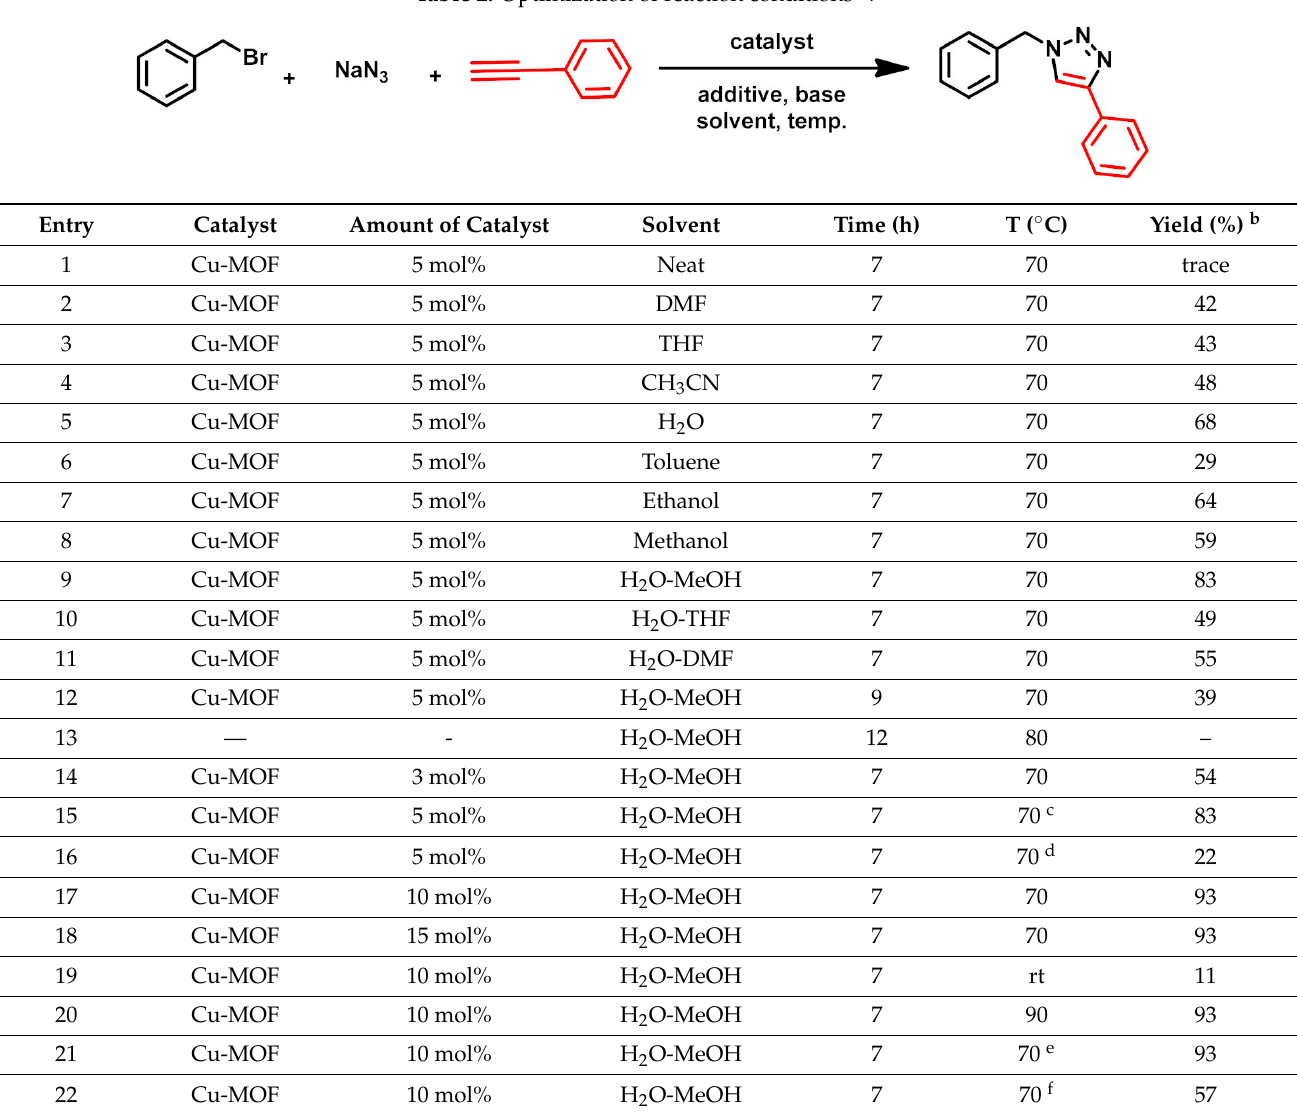
Table 2. Optimization of reaction conditions a